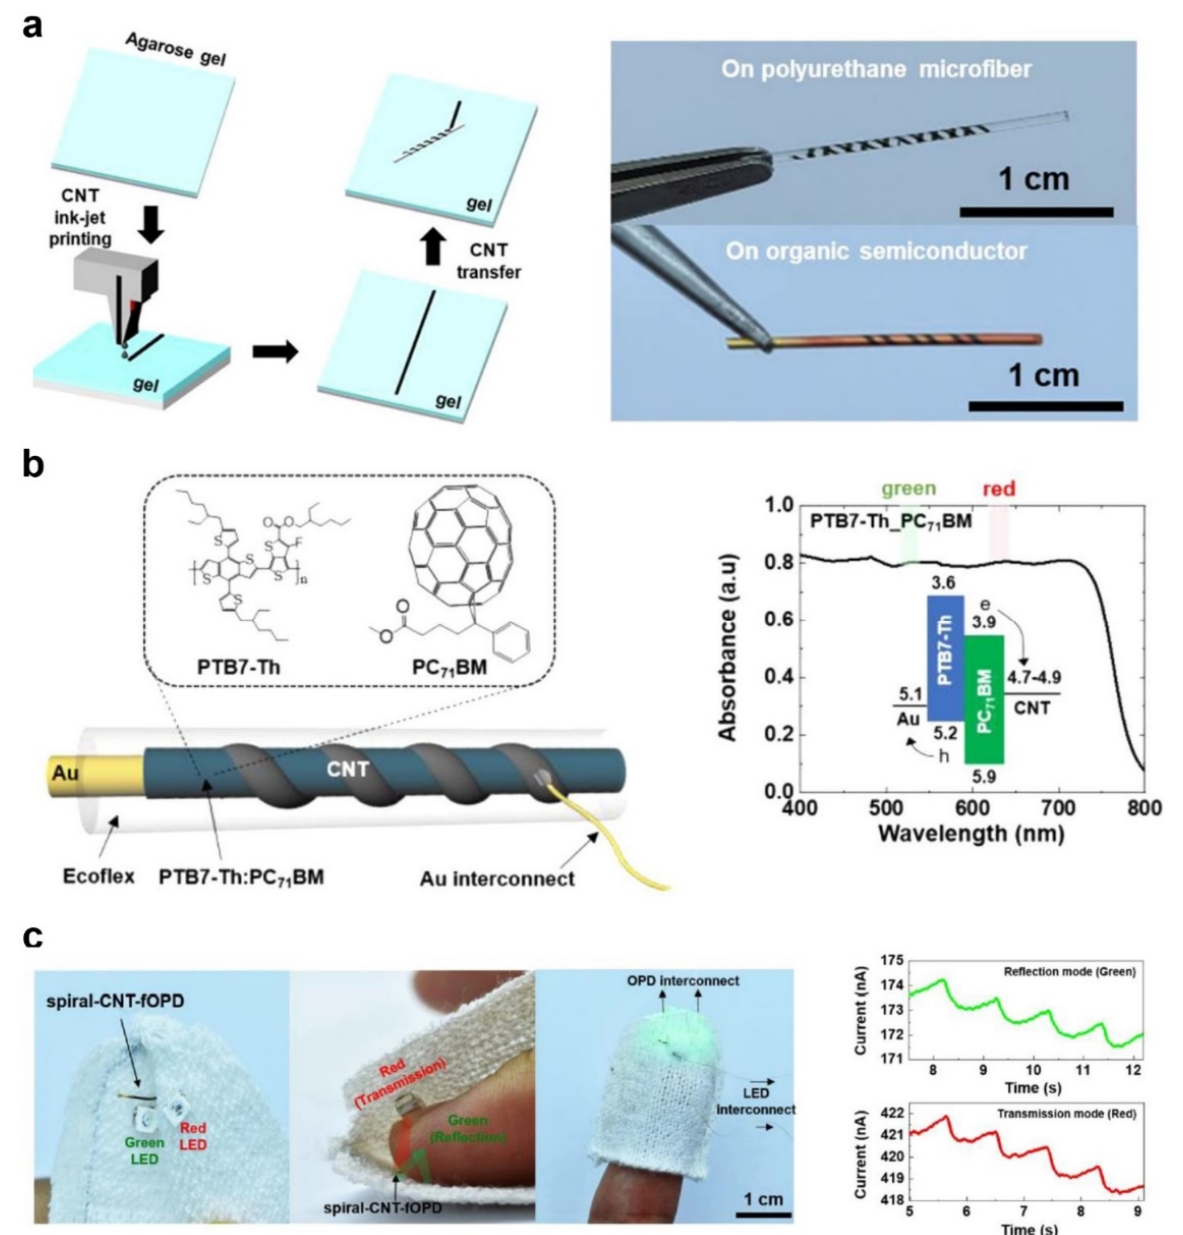
Figure 12. ( a ) Schematic illustration of the fabrication of CNT microelectrodes using inkjet and rolling-transfer techniques. ( b ) Schematic illustration of the device structure of an organic photodiode, chemical structure of PTB7-Th and PC 71 BM, and absorption spectrum of the PTB7-Th:PC 71 BM photoactive layer. ( c ) Photographs of green and red light-emitting diodes and photodiodes embedded in the textiles for the measurement of PPG signals and PPG signals from the photodiodes in the reflection and transmission modes. Reprinted from [72], copyright 2022 with permission from American Chemical Society.